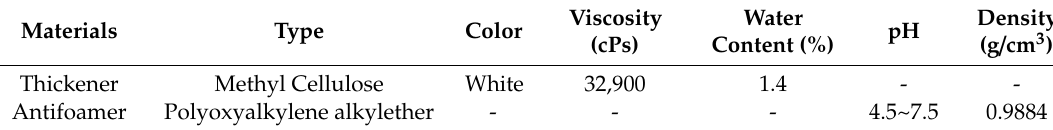
Table 3. Mix proportion used for the manufacturing of liquefied red